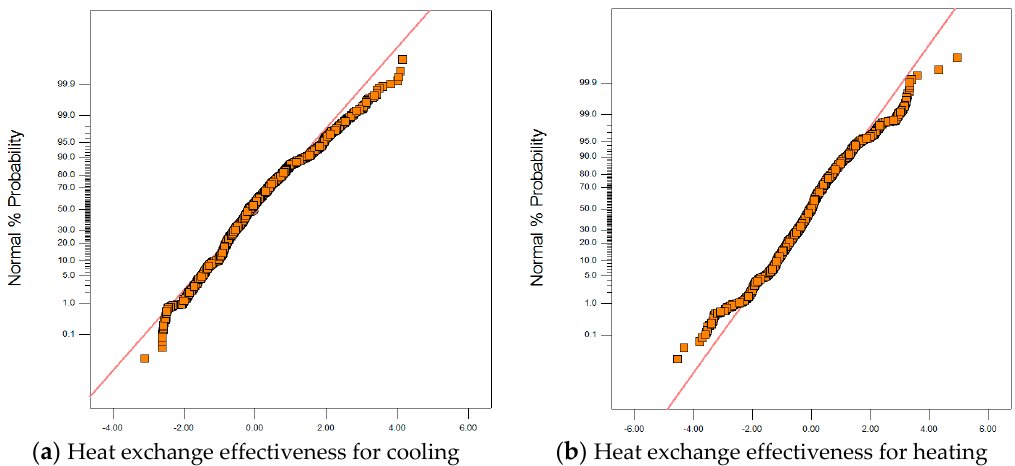
Figure 4. Normal plot of residuals.